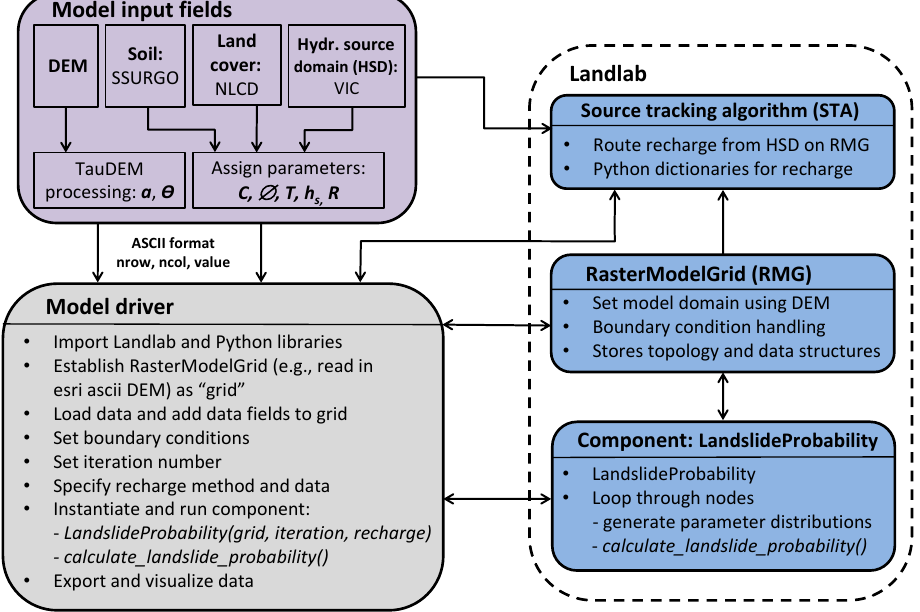
Figure 1. Workflow for landslide modeling using the Landlab LandslideProbability component. The user creates input parameter fields (purple box). The model driver (gray) imports Landlab, Python libraries, and model parameter fields; instantiates (i.e., creates an instance of) the RasterModelGrid and the component; and runs utilities and the Landlab component (blue boxes inside dashed